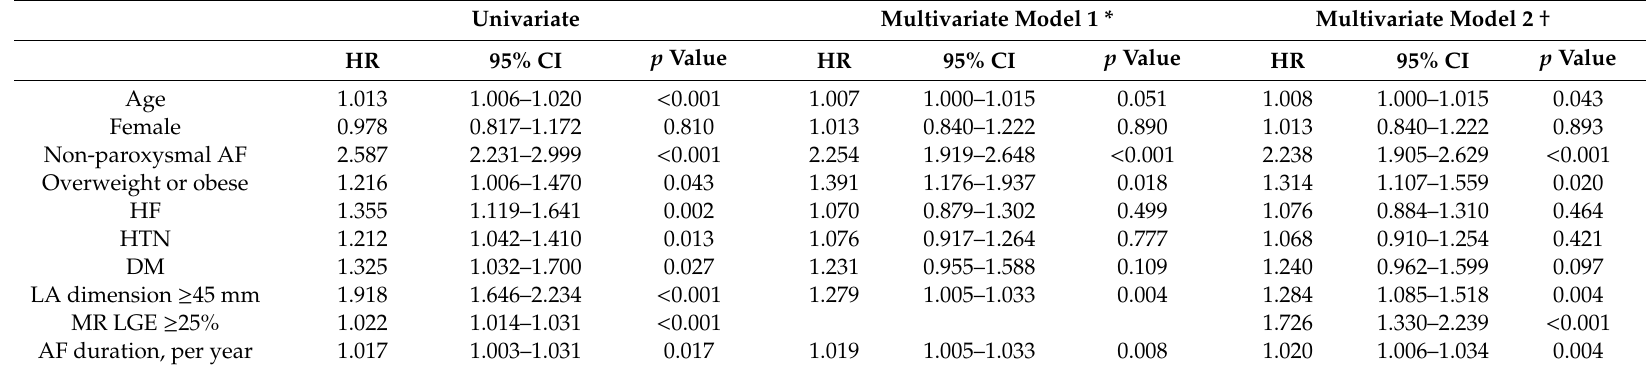
Table 3. Clinical predictors of atrial fibrillation recurrence after catheter